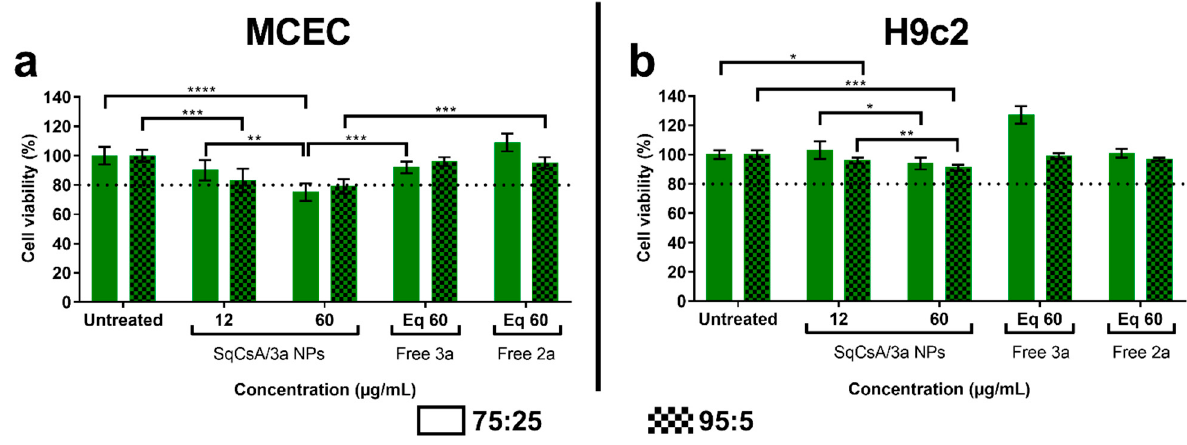
Figure 6. Cell viability assessment of Mouse Cardiac Endothelial Cells (MCEC) ( a ) and H9c2 ( b ) cells treated with SqCsA/ 3a nanoparticles. Cell viability was expressed as a percentage of the viability of untreated cells. An equivalent concentration (eq) of free bioconjugate 3a and the free peptide ( 2a ) contained in the nanoparticles at the highest concentration was used as control. * p ≤ 0.05, ** p ≤ 0.01, *** p ≤ 0.001, **** p ≤ 0.0001.